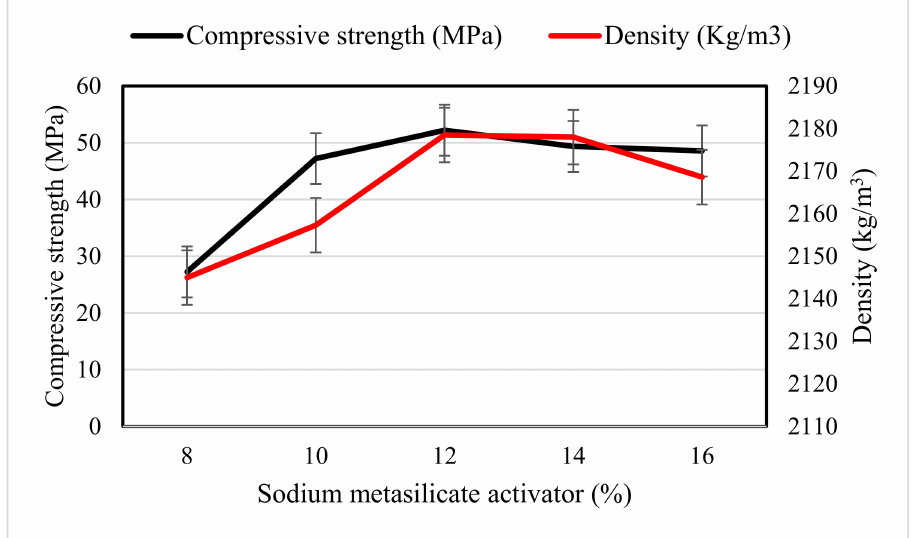
Figure 5. Compressive strength and density of OPAAB at 28